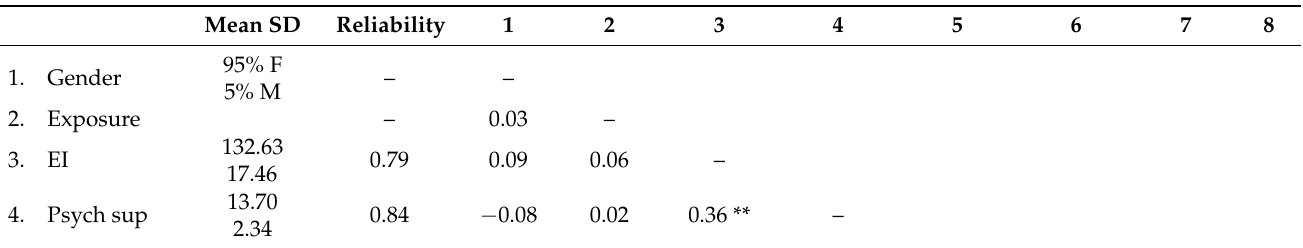
Table 1. Descriptive Statistics and Zero-Order Correlations among Main Study Variables (n =